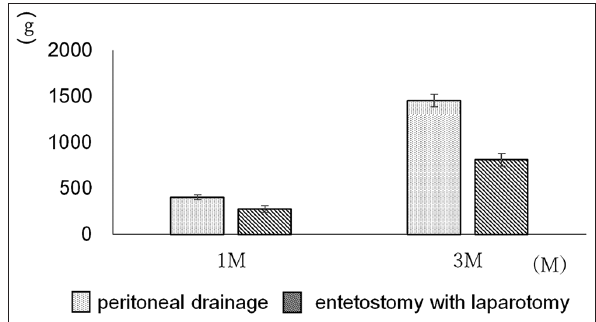
Fig ure 2: Comparison of post-operative weight gain in the peritoneal drainage group and the enterostomy with laparotomy